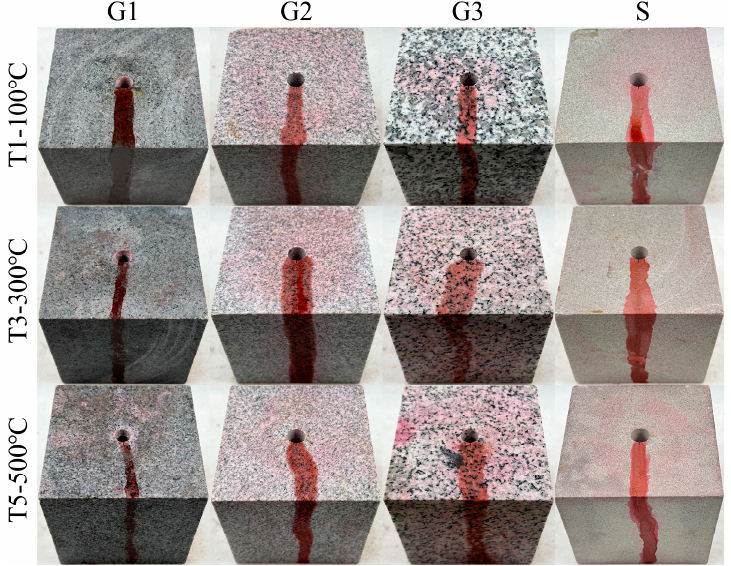
Figure 10. Photograph of SFS specimens of G1, G2, G3, and S lithologies after fracturing.